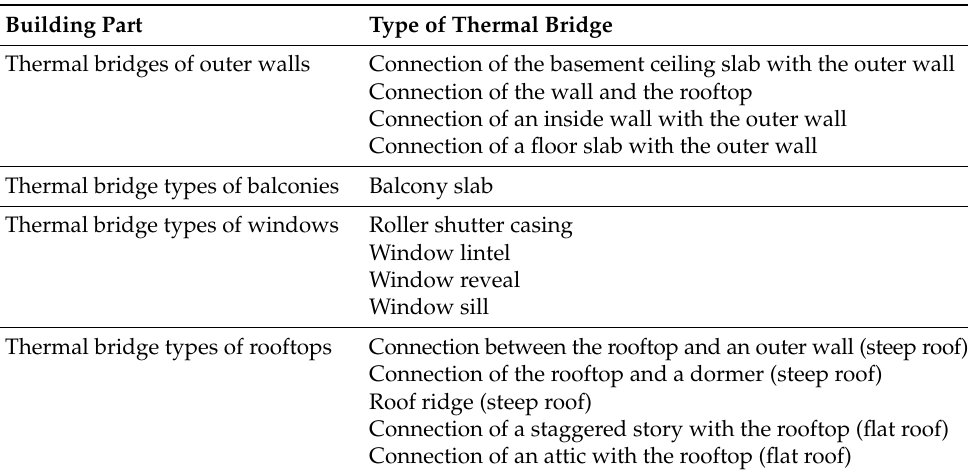
Table 1. Types of thermal bridges sorted by the building parts in which they